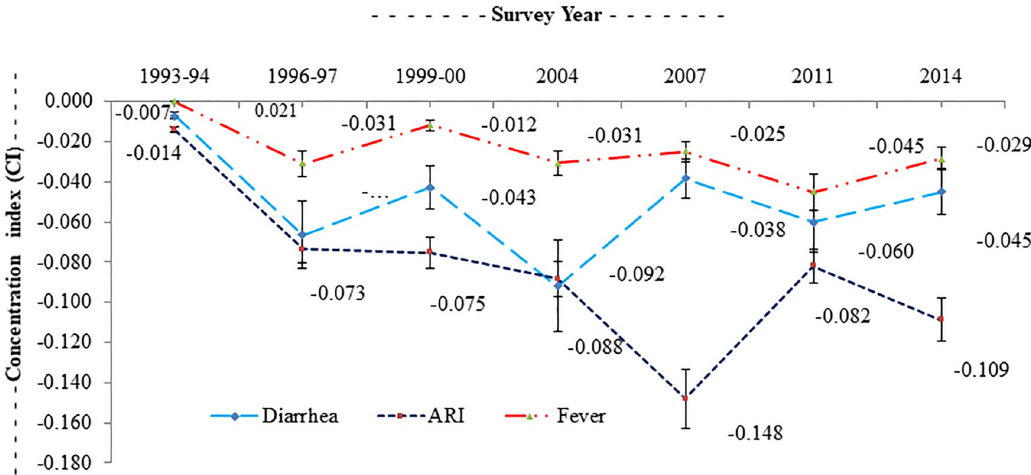
Fig 3. Trend of inequity in childhood morbidities, 1993–2014. The concentration curves (CC) for diarrhea, ARI, and fever in 1993/94 (1996/97 for fever) and 2014 (Fig 4).